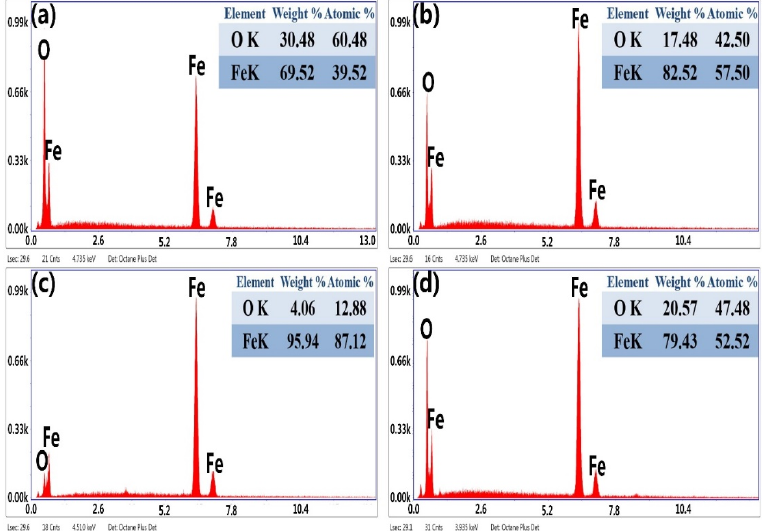
Figure 3. Element composition and relative content (at. %) of the reaction layer of the sample at points ( a ) 1, ( b ) 2, ( c ) 3, and ( d ) 4 marked in Figure 2.